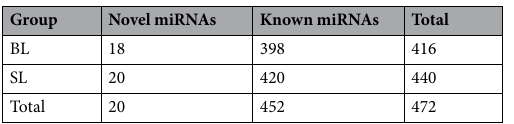
Table 2. Numbers of known and novel miRNAs in castrated and intact